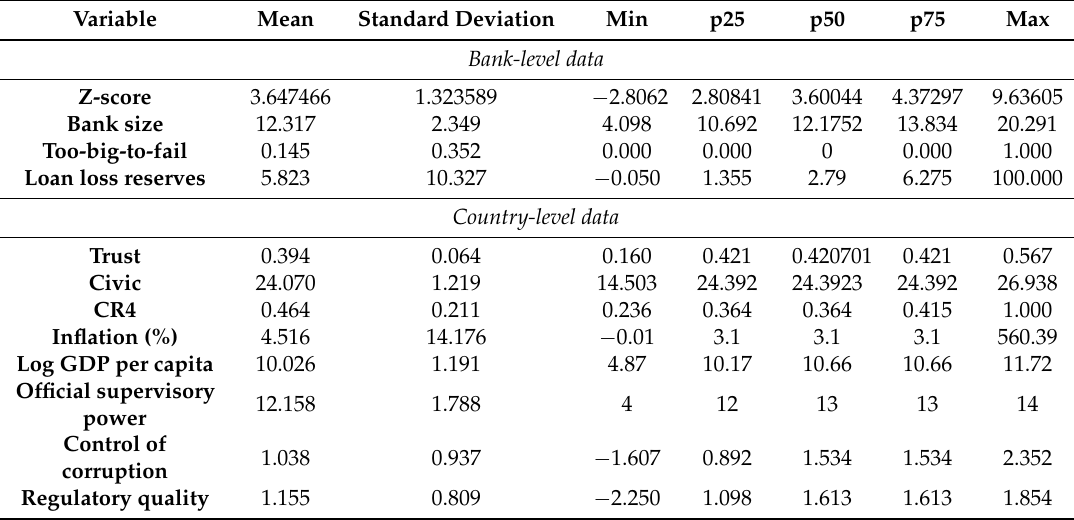
Table 1. Summary